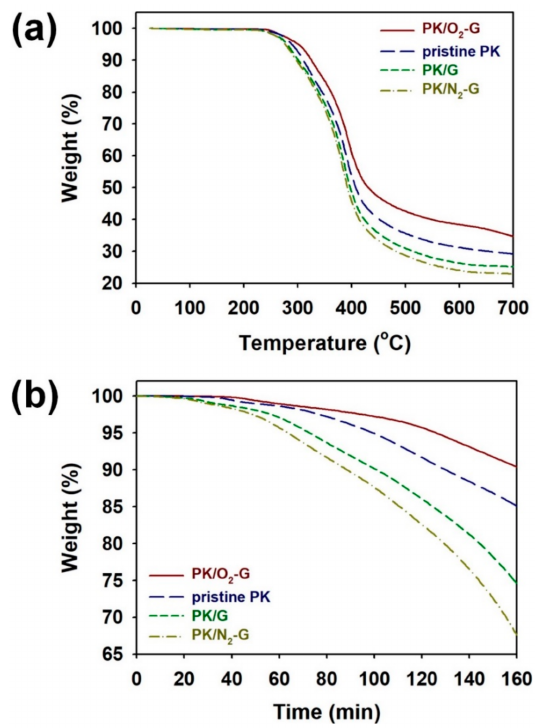
Figure 9. ( a ) TGA curves and ( b ) isothermal TGA curves (at 250 ◦ C) of PK/O 2 -G, pristine PK, PK/G and PK/N 2 -G.